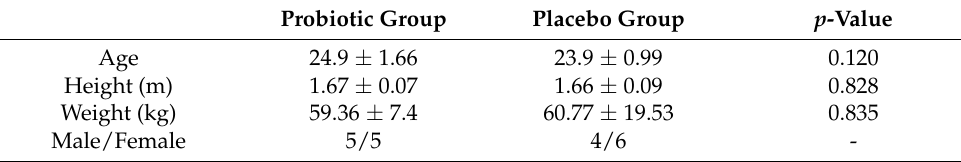
All values are presented as mean (SD).